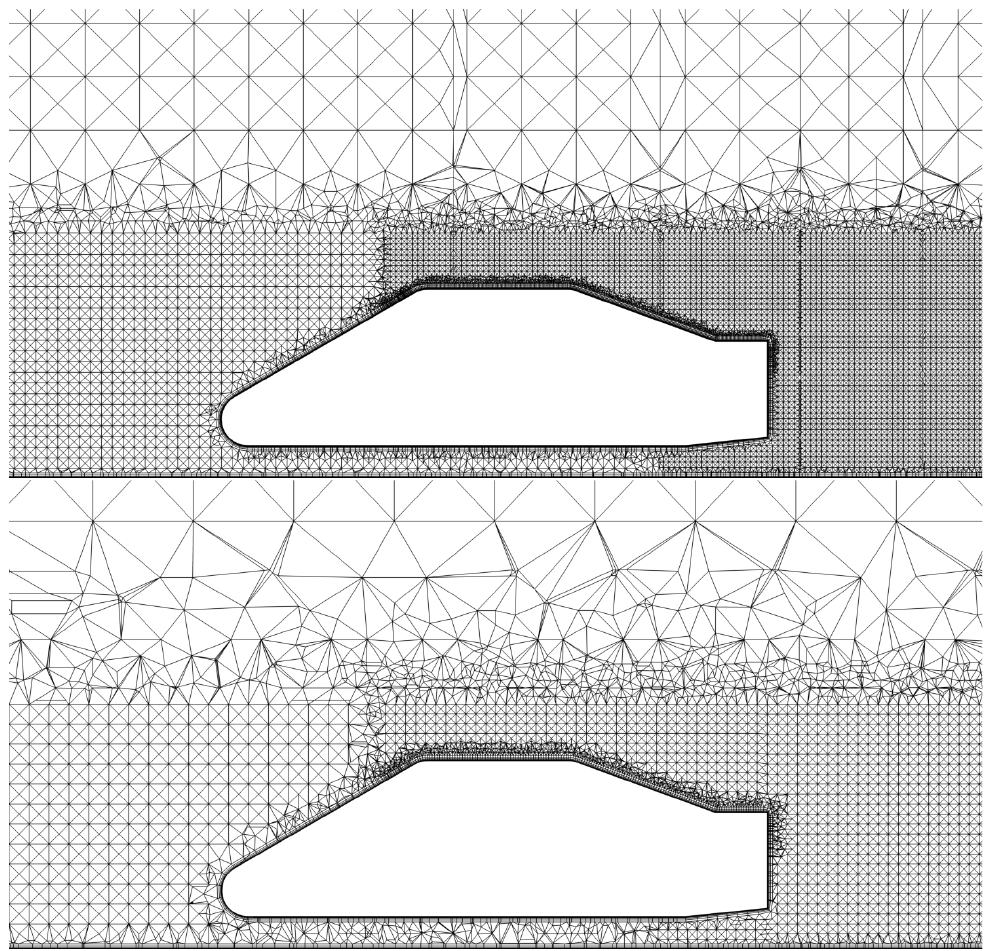
Figure 5. Meshes at the centreline. ( Top ) HFP3 and ( Bottom ) HCP5